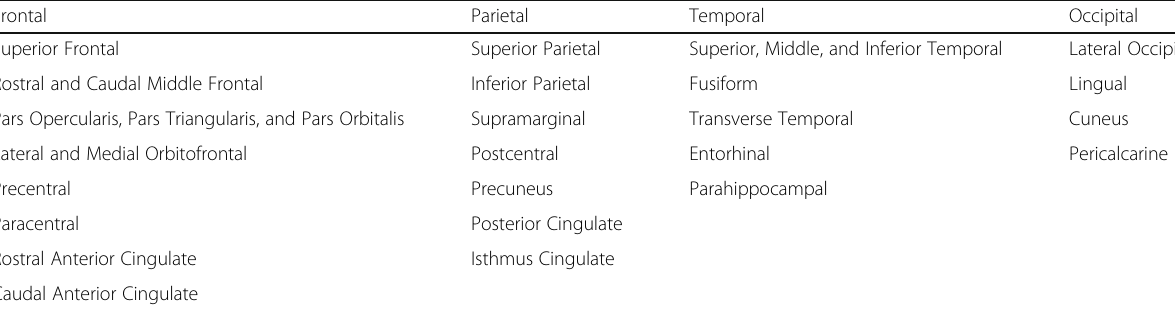
Table 2 Definition of lobes based on Freesurfer labels